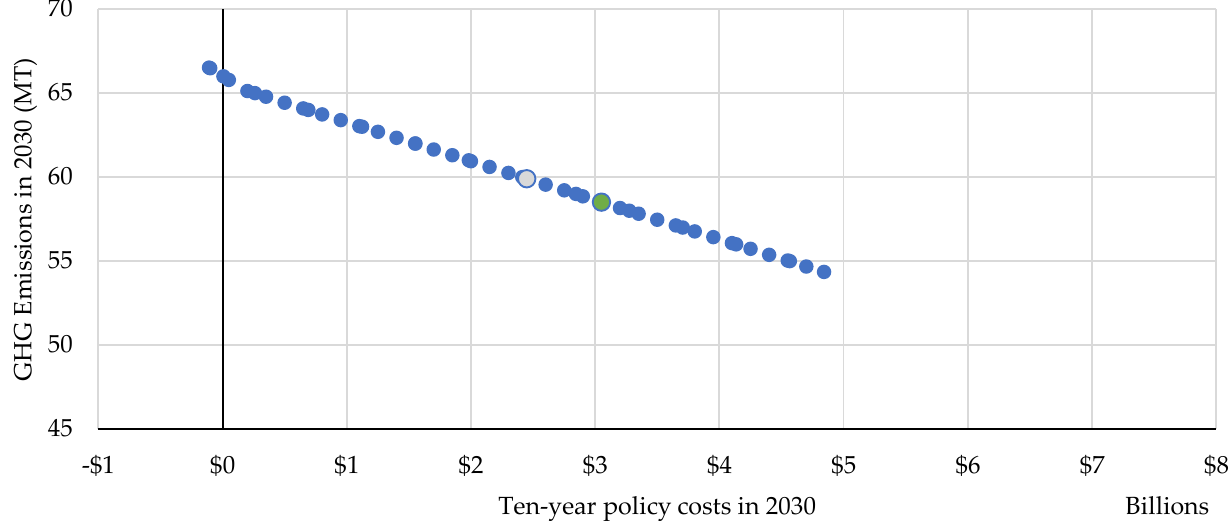
Figure A3. Pareto front 3 calculated from the MIO model. Assumes LDV fleet is 25% EV in 2030 (low-EV) and upper-bound TCO (high-TCO). Green and grey points represent the two policy sce- narios (~3$ billion ten-year policy costs in 2030 and 40% GHG reduction relative to 2005 levels in year 2030) presented in Section 4.